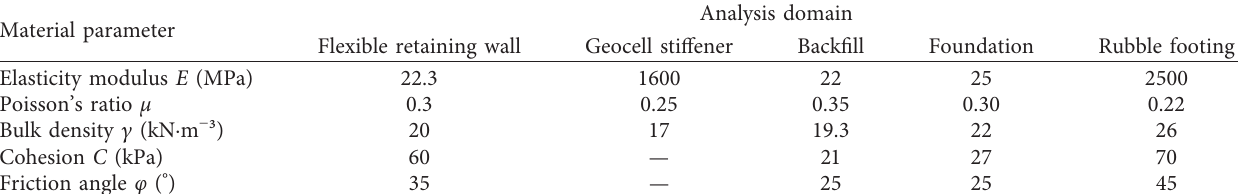
Table 3: Relevant numerical calculation parameters.